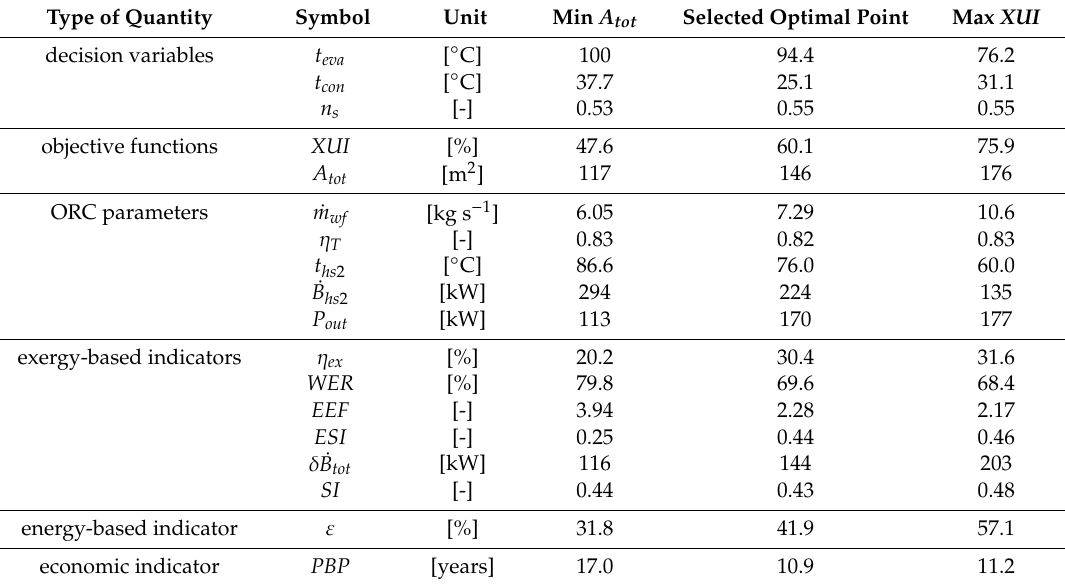
Table 4. Results of the multi-objective